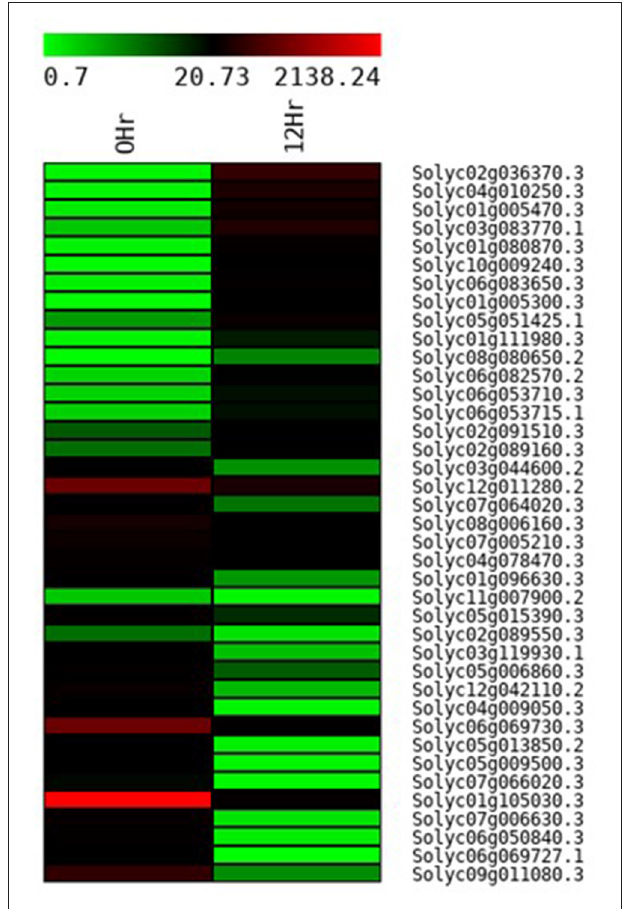
FIGURE 7 | Heat map displaying the change in the expression pattern of genes in tomato plant on the treatment with Cg-2 biocontrol agent. (Green to black to red marks the increase in the expression of